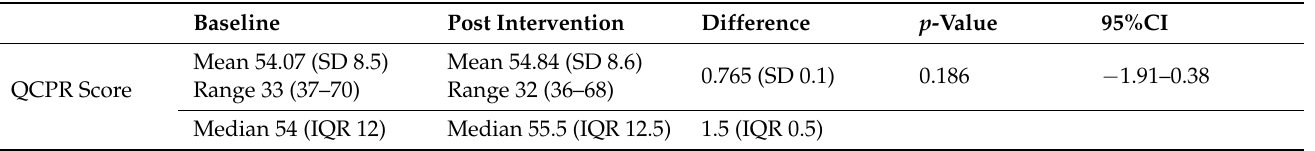
Table 4. QCPR results for HOMESIDE